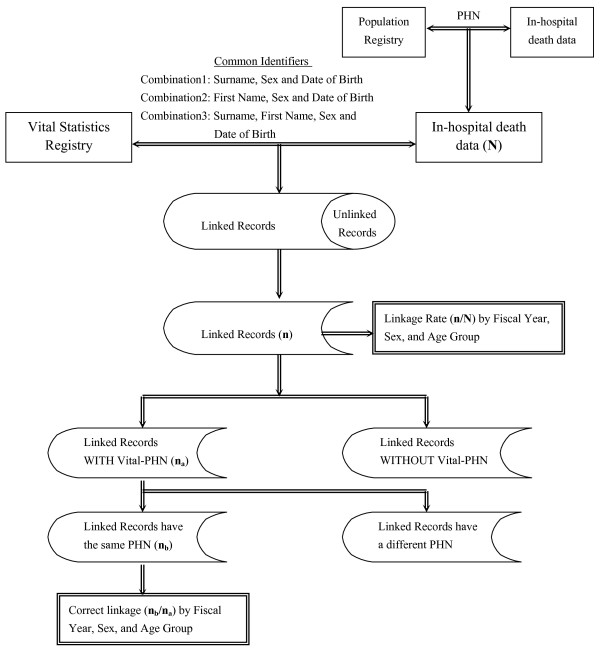
Matching Process between Vital Statistics registry and In-hospital death data.